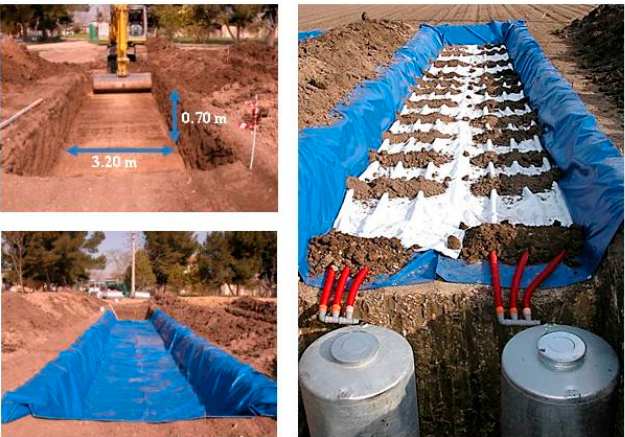
Figure 1. A lysimeter-like installation was set up allowing the recovery of the water drained from the 0.70 m soil profile and collected by draining perforated pipes placed along the bottom of each basin and connected to tanks located underground at the head of each field